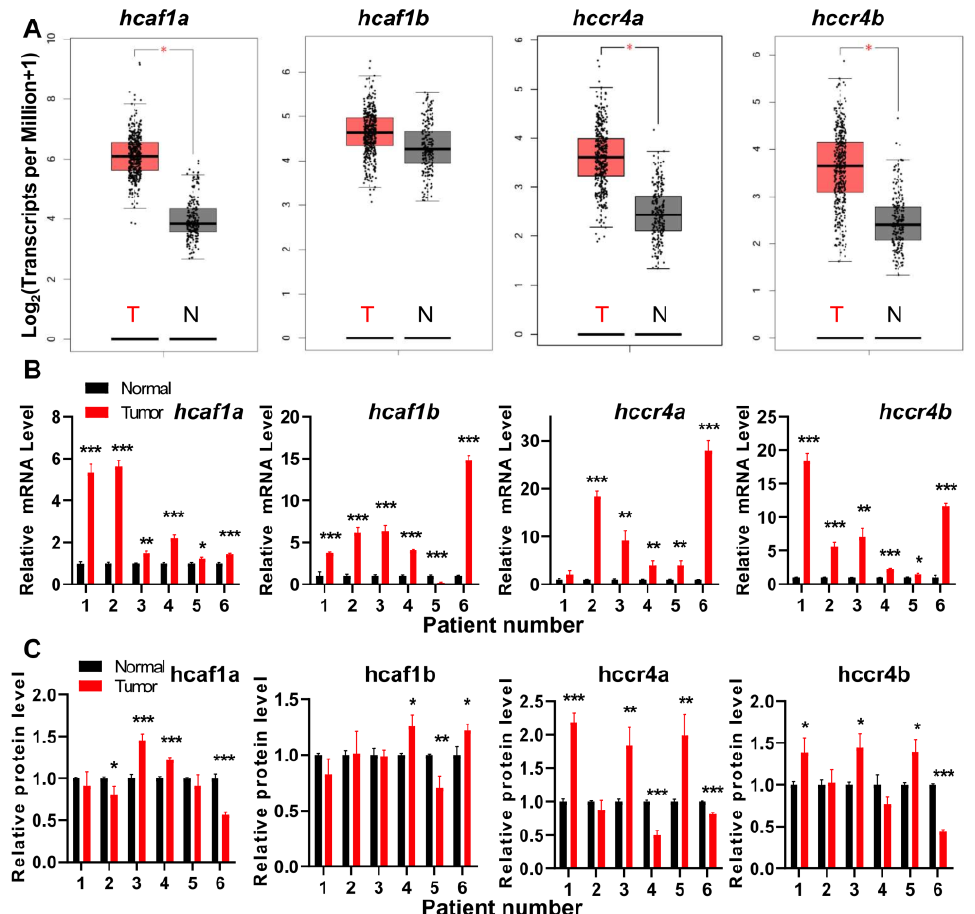
Figure 1. The human Ccr4 (hCcr4)a/b and human Caf1 (hCaf1)a/b deadenylases were dysregulated in gastric cancers. ( A ) Expression profiles of the four deadenylases in stomach adenocarcinoma (STAD) database analyzed by the web server GEPIA; ( B ) Changes in the mRNA levels of the four deadenylases in patient samples analyzed by qPCR using β -actin as the internal control ( n = 3); ( C ) Changes in protein levels of the four deadenylases in patient samples analyzed by Western blot using GAPDH as the internal control ( n = 3). All experiments were performed with three biological replicates and the data were normalized by taking the control (normal) in each replicate as 1.0. * p < 0.05, ** p < 0.01, and *** p <